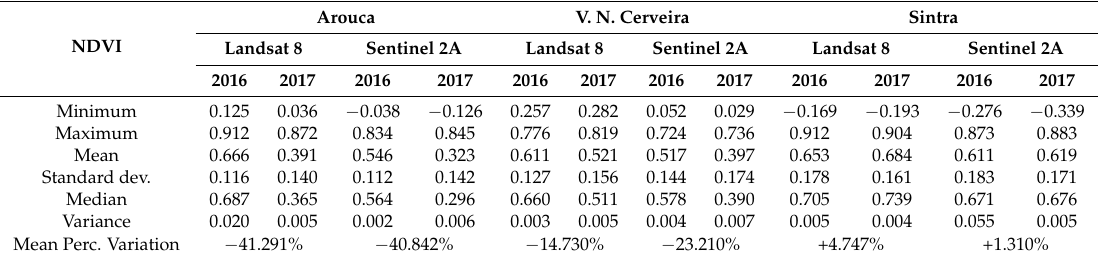
Table 4. NDVI statistical analysis for the selected areas of the three municipalities analyzed.